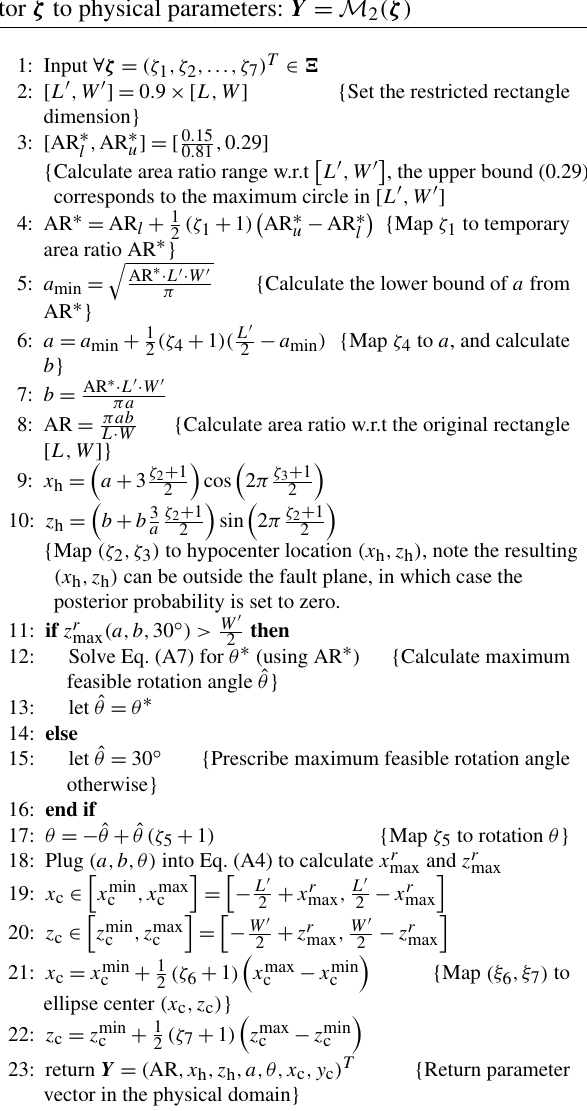
Algorithm 2 Restricted mapping – auxiliary parameter